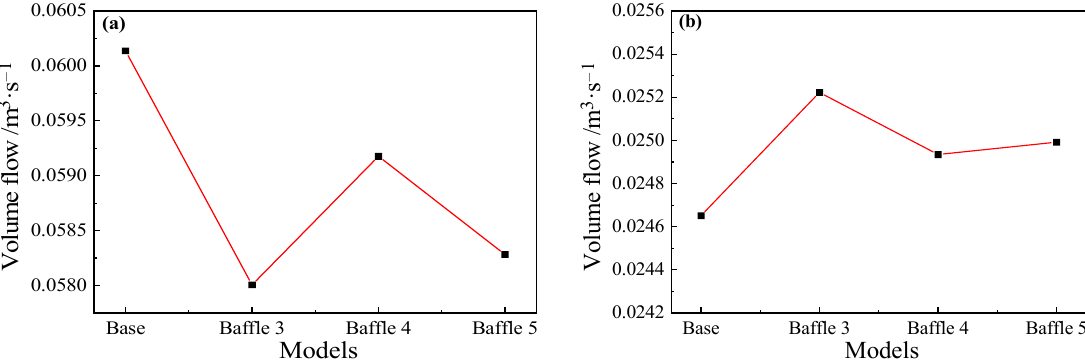
Figure 23. Volume flow at positions: ( a ) upstream (4.5 m); and ( b ) downstream (5.2 m) of the baffle for main troughs with different widths.